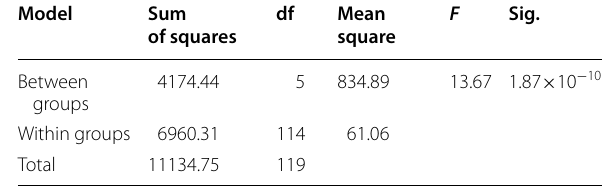
Table 6 Variance analysis results of aisle width